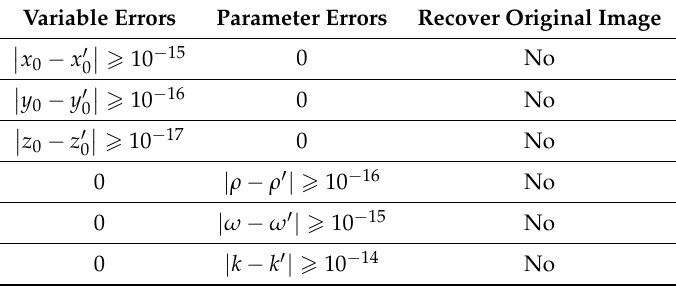
Figure 10. ( a ) recovered image with initial value y (cid:48) Table 1. Test results of key sensitivity for the parameters and initial variables of VdPVP (Van der Pol oscillator with variable